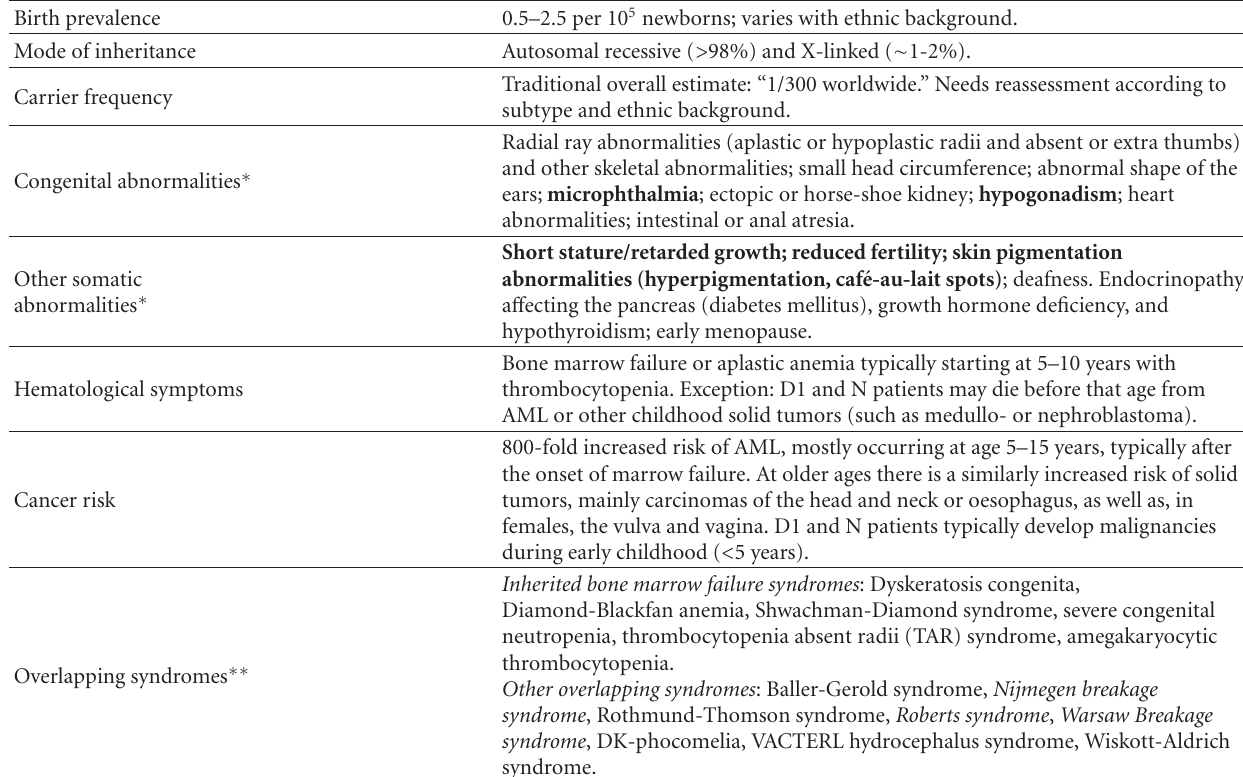
Table 1: General features and symptoms associated with Fanconi